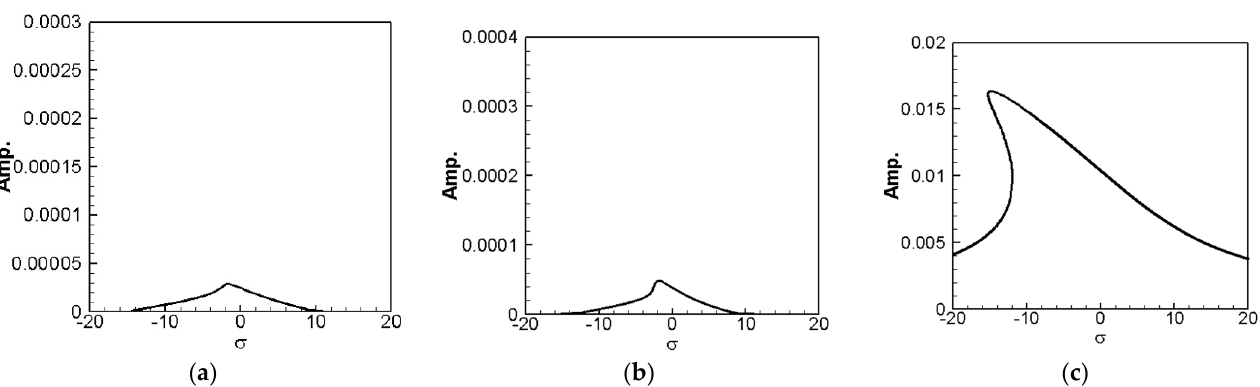
Figure 6. SES system fixed points plots of the 3rd mode being excited. ( a ) 1st mode response, ( b ) 2nd mode response, and ( c ) 3rd mode response.